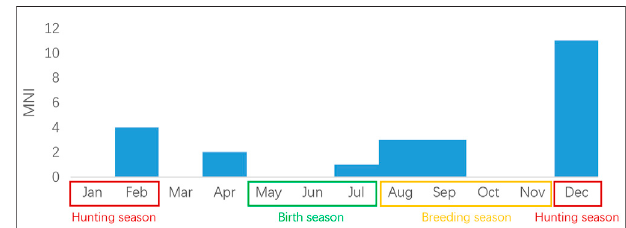
FIGURE 7 | Distribution of the death month of sika deer from Tianluoshan.